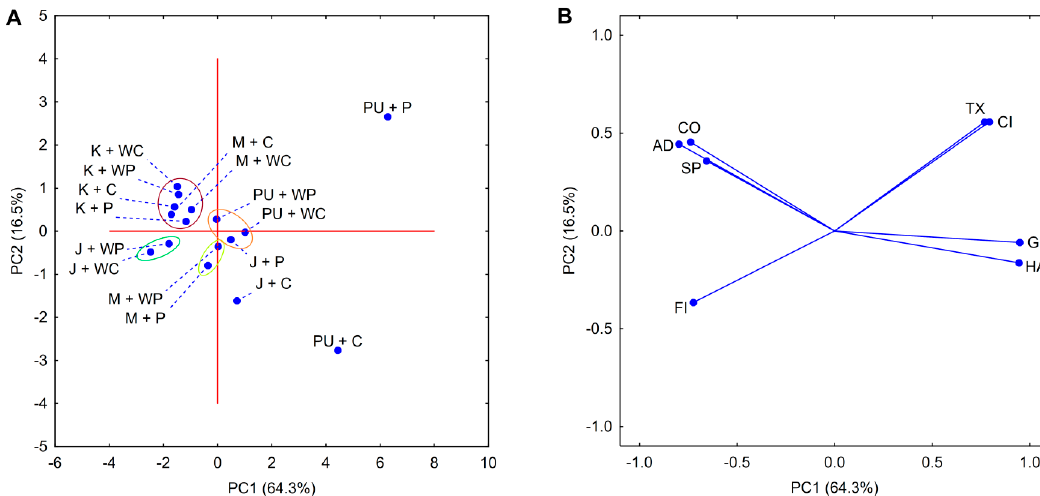
Figure 8. PCA score ( A ); loadings plot ( B ); rheological and texture properties of food products